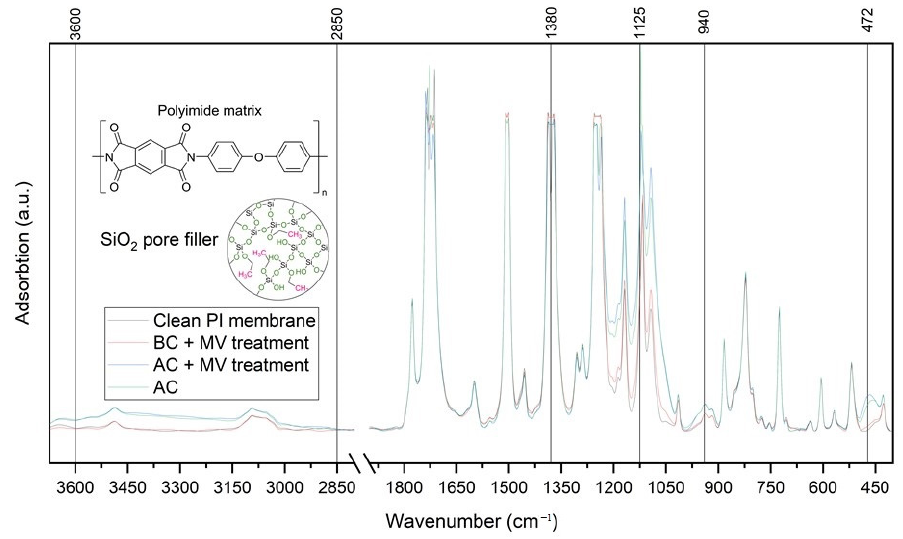
Figure 4. FTIR spectra of composite films based on track membranes.